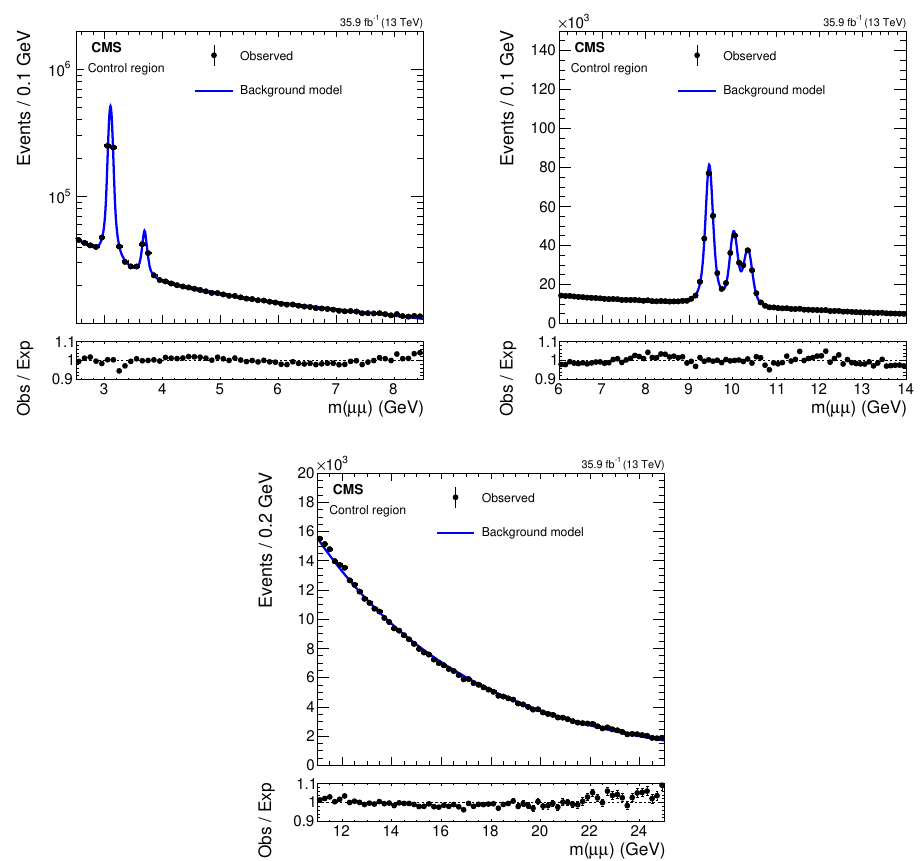
Figure 3 . Background model (cid:12)ts and observed data in the control region m ( (cid:22)(cid:22) ) distribution. The (cid:12)gures are divided into three (cid:12)t ranges: 2 : 5 < m ( (cid:22)(cid:22) ) < 8 : 5 GeV (upper left), 6 < m ( (cid:22)(cid:22) ) < 14 GeV (upper right), and 11 < m ( (cid:22)(cid:22) ) < 25 GeV (lower). is 0.2{5.0%; most muons have p < 100 GeV and thus an uncertainty of 0.2% [58]. For T the (cid:28) reconstruction, there is an uncertainty in the (cid:28) identi(cid:12)cation e(cid:14)ciency of 5{18%, h h varying with p ( (cid:28) ), and an uncertainty in the (cid:28) energy scale of 1.2{3.0% [63], varying T h h with the number of charged and neutral hadrons in the (cid:28) h